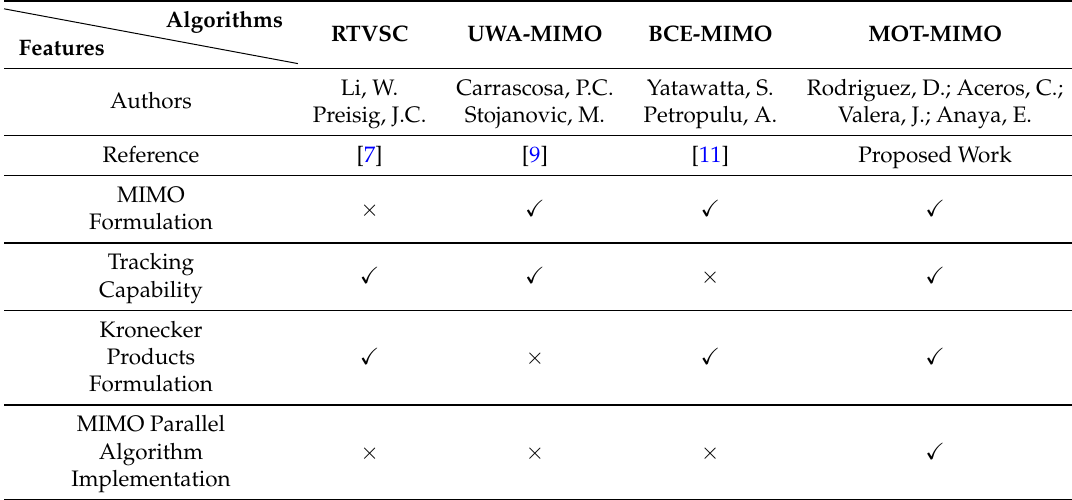
Table 1. Attributes of selected channel estimation algorithms. MOT, multiple object